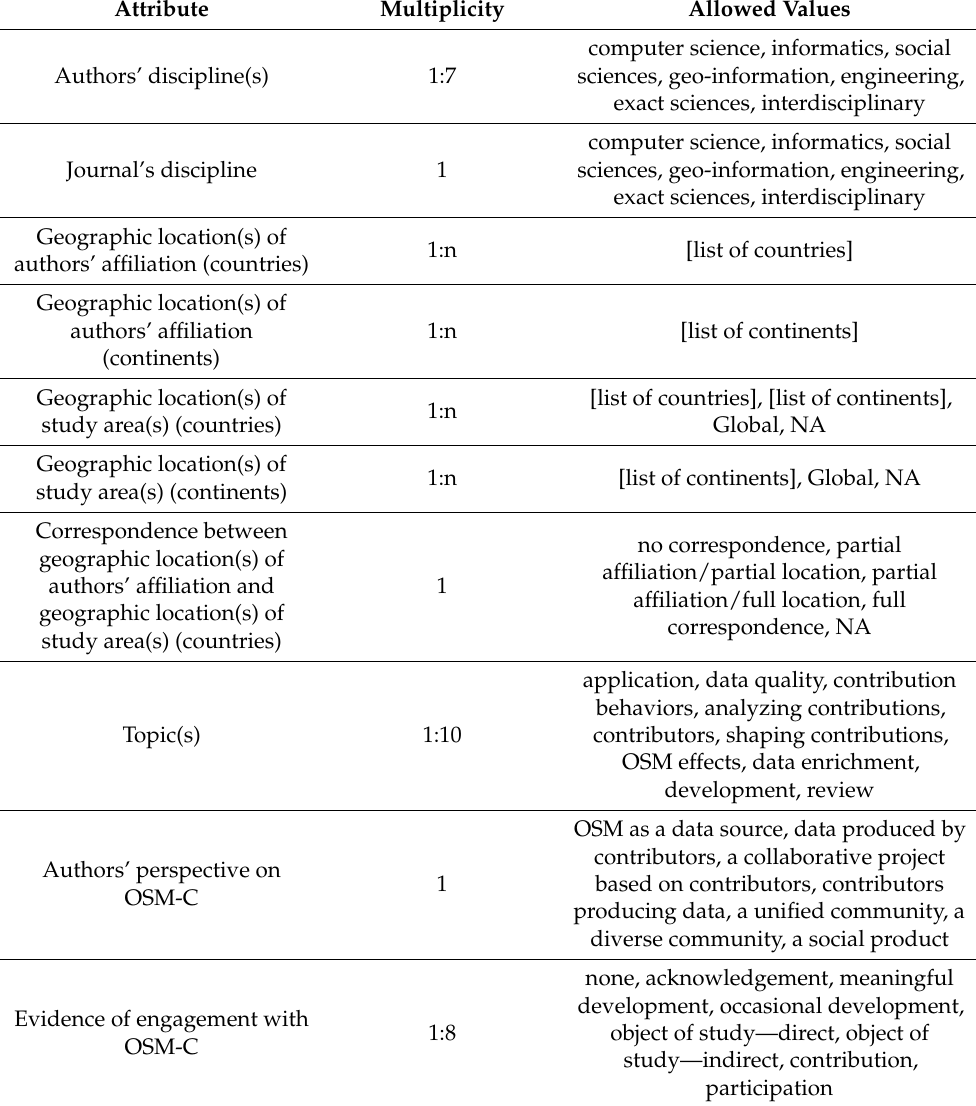
Table 1. Attributes, with their multiplicity and allowed values, manually classified for each OSM paper published between 2016 and